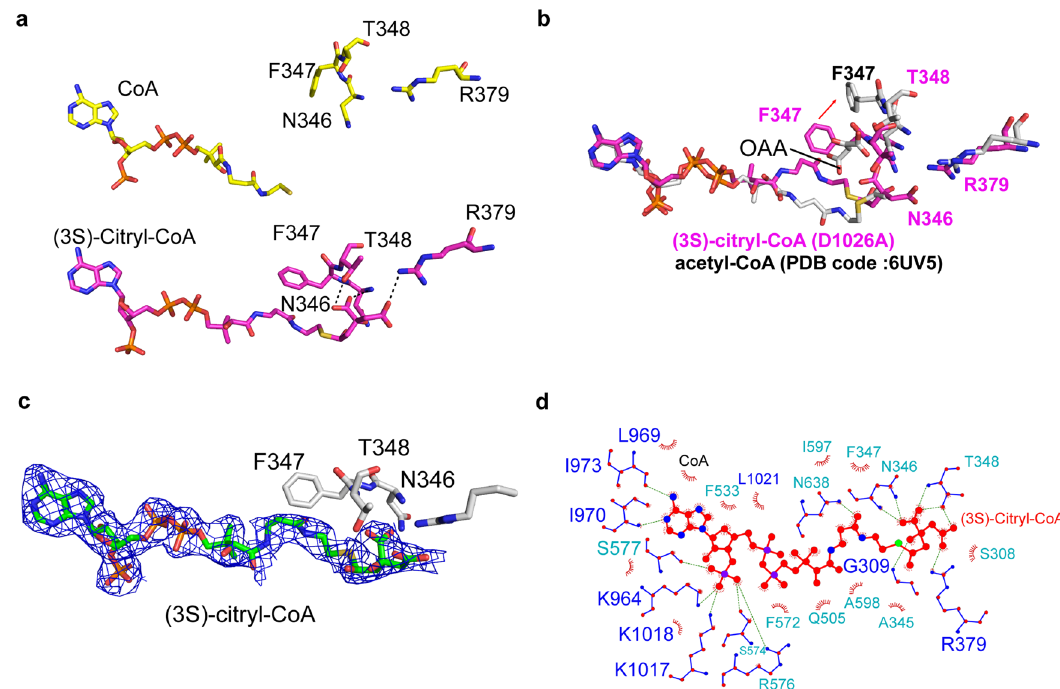
Fig. 3 | (3S)-Citryl-CoA binding sites in the ASH domain of ACLY-D1026A with substrates.a ComparisonofCoAand(3S)-Citryl-CoAboundtotheASHdomainof ACLY-WT bound to CoA (PDB 6UUZ) and ACLY-D1026A — substrates structures, respectively.Residuesthatchangepositionstoaccommodatethedifferentligands are highlighted. b Overlay of ACLY-D1026A — substrates and ACLY-WT bound to